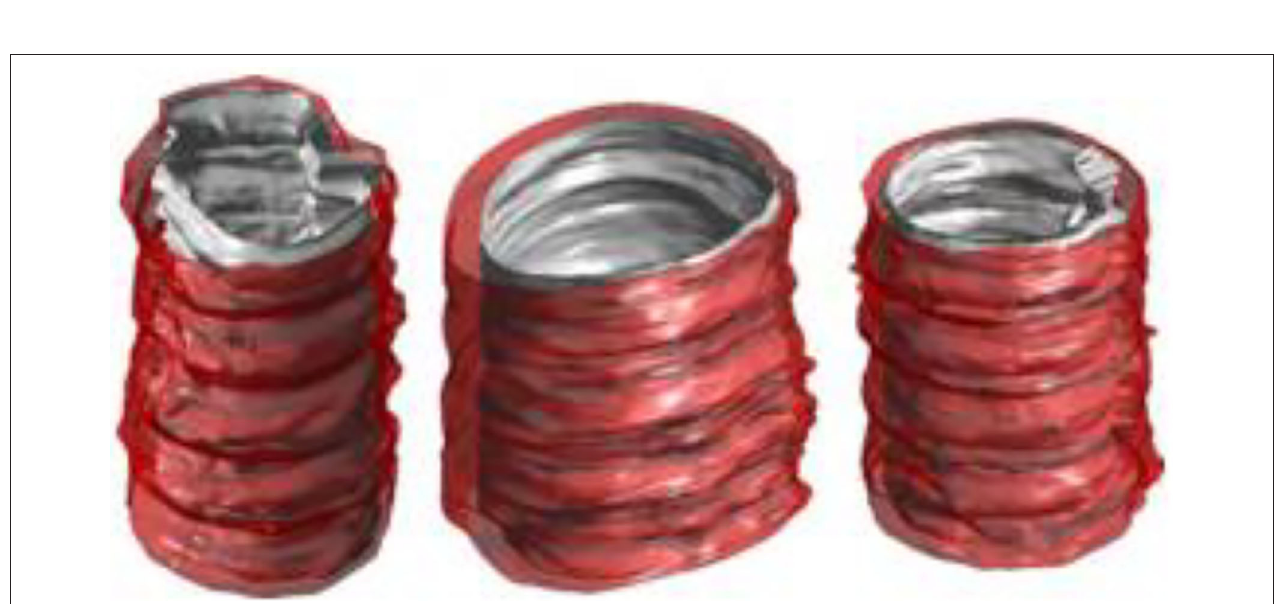
FIGURE 8 | New type of intravascular ultrasound image sequence blood vessel reconstruction results.